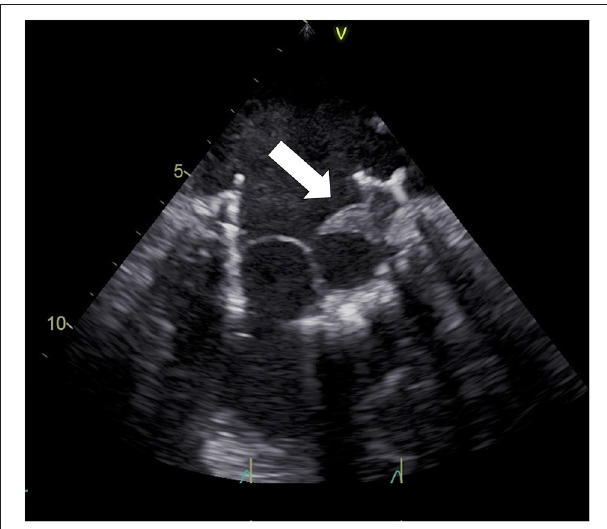
FIGURE 3 | Transesophageal echocardiography showing Tiara (Neovasc) anterior leaflet